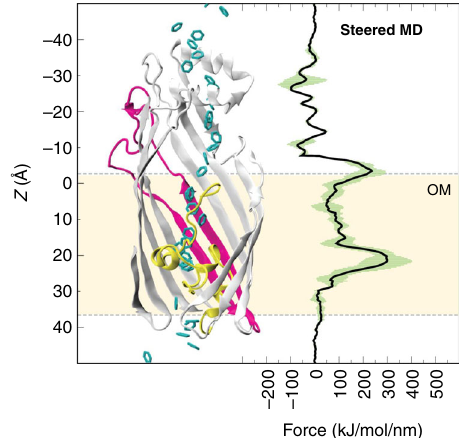
Fig. 6 Steered MD reveals barriers for benzene permeation. An overlaid force pro fi le from the steered MD simulations via the classical pathway (right) on the cartoon representation of TodX, with benzene positions shown along the reaction coordinate (centre). The TodX plug domain is coloured yellow, S2 and S3 are coloured magenta. Standard deviations are shown in